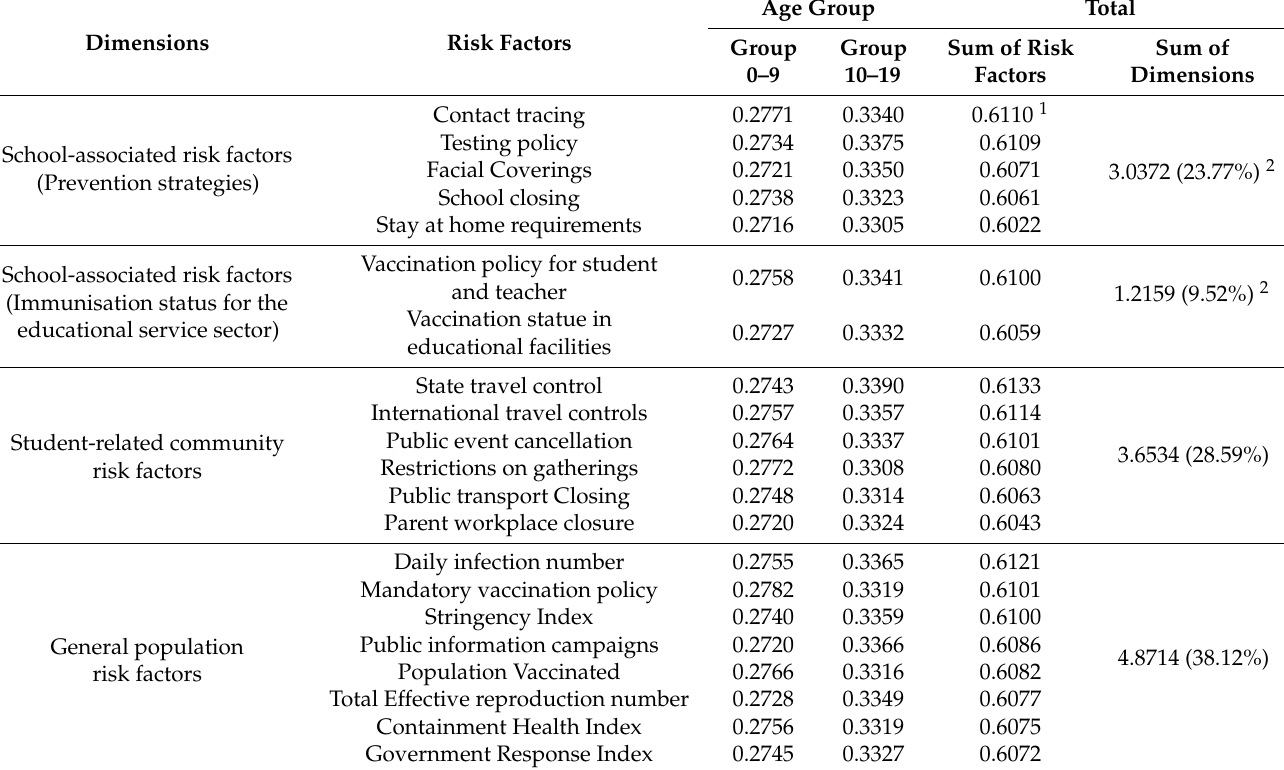
Table 4. Impact score of dimensions for age groups 0–9 and